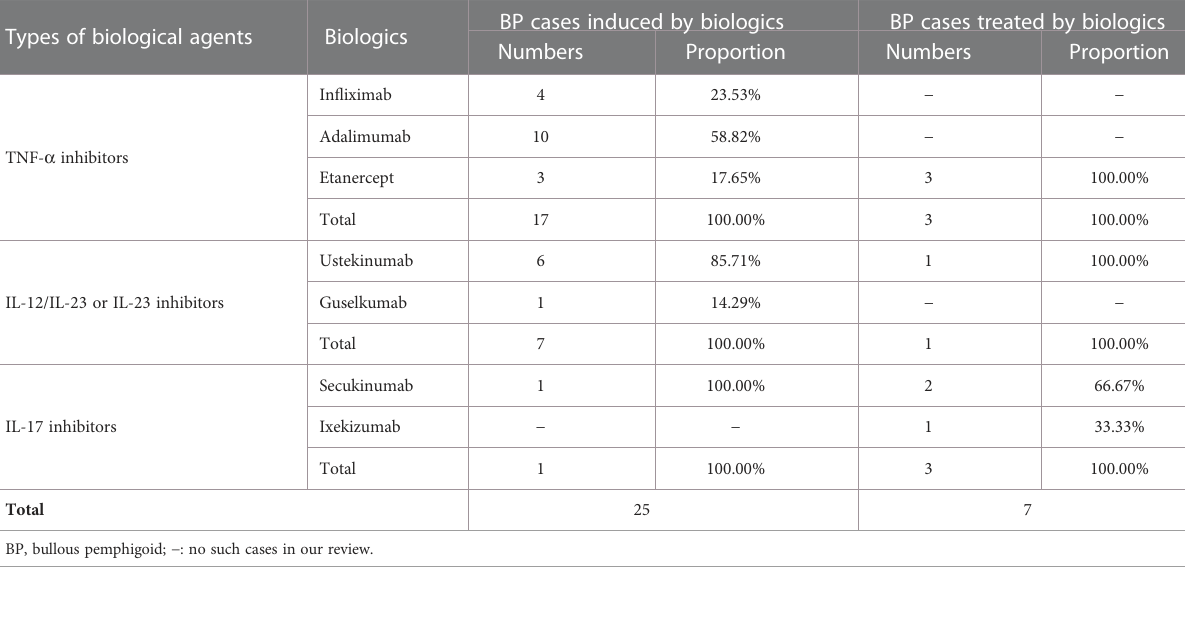
TABLE 2 Statistics of BP cases induced and treated by biologics.